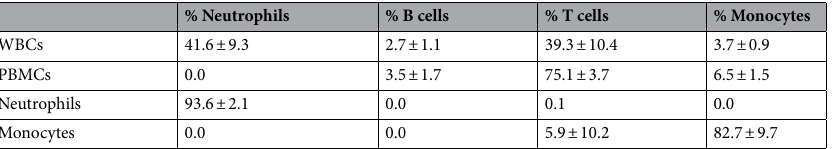
Table 1. Relative levels of leukocytes in blood from four healthy donors. WBCs, white blood cells. Neutrophils obtained via negative selection from whole blood and identified as CD45 + CD15 + CD16 + . B and T cells identified as CD45 + CD3 − CD20 + and CD45 + CD3 + CD20 - , respectively. Monocytes were purified via negative selection from PBMCs and identified as CD45 + CD3 − CD20 − CD14 + . (average ± S.D. values are